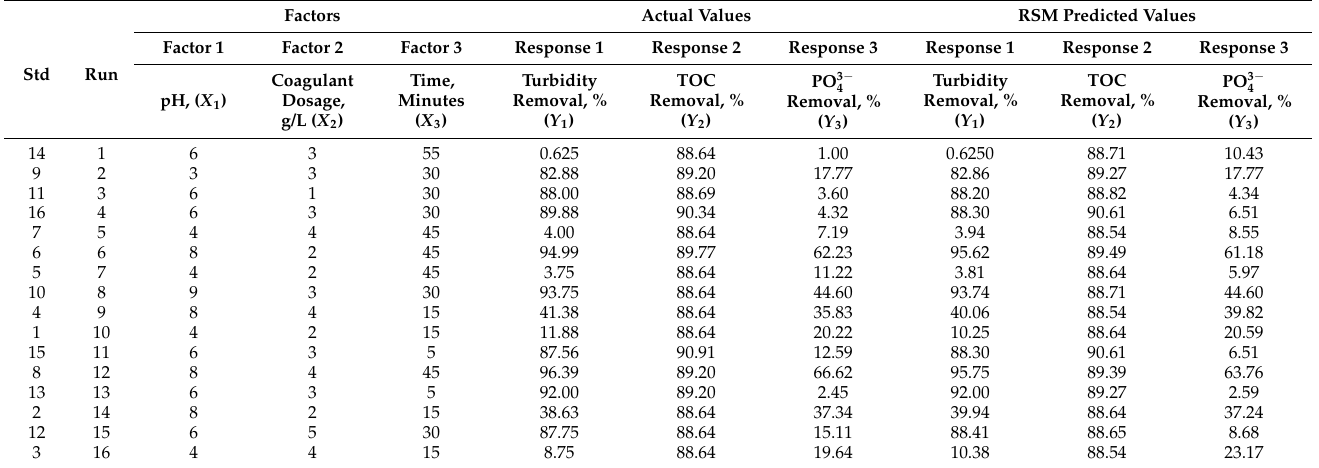
Table 3. Comparison between experimental response and model predicted response.